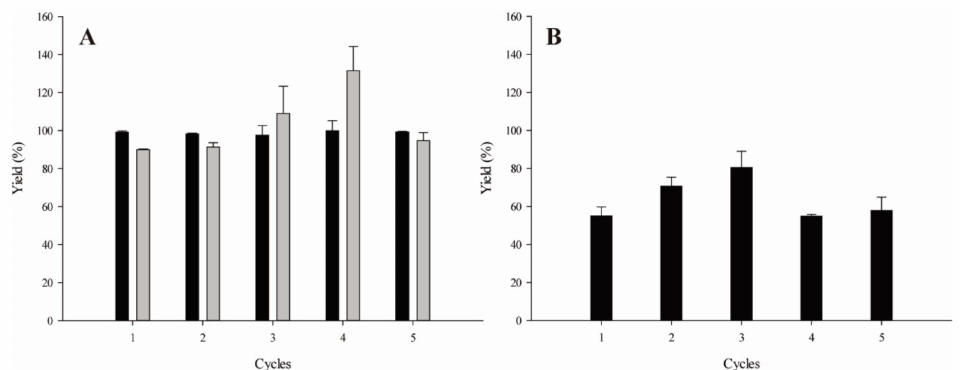
Figure 1. Esterification yield (%) of butyric acid ( A ) and acetic acid ( B ) with isoamyl alcohol in cyclohexane (black) and hexane (grey). The isoamyl butyrate synthesis reaction was extended for 5 h and the isoamyl acetate synthesis reaction for 24